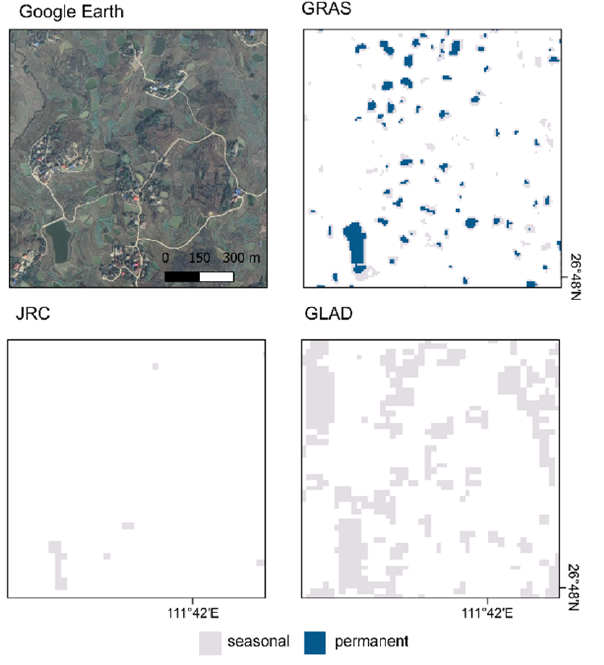
Figure 9. Surface water mapping by GRAS-SWD, JRC-GSWE and GLAD-GSWD over the location in Hunan province with many small water bodies. High-resolution image from Google Earth, shown as a reference.